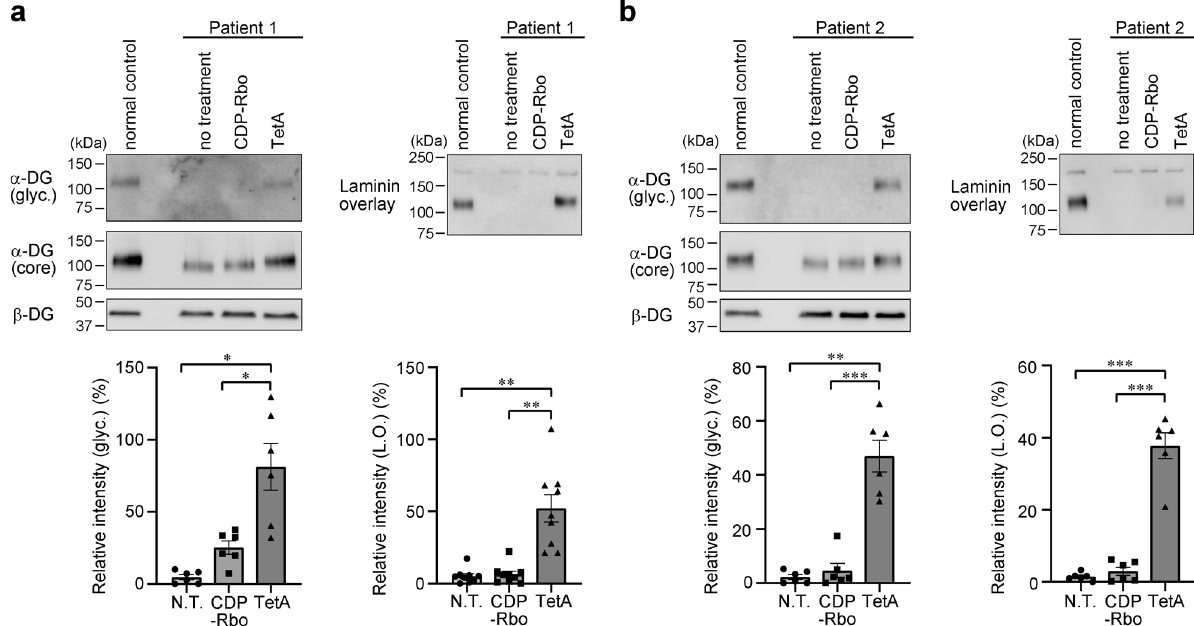
Fig. 6 CDP-Rbo(TetA) treatment recovers α -DG glycosylation in patient fi broblasts. Two different fi broblast cell lines derived from human patients ( a ; Walker-Warburg syndrome patient, b ; muscle-eye-brain disease patient) with ISPD-de fi ciency were treated with CDP-Rbo (200 μ M) or CDP-Rbo(TetA) (200 μ M) for 24 h. α -DG glycosylation was measured using western blot analysis with antibodies against matriglycan (glyc., IIH6) and core protein (3D7) or a laminin overlay assay. β -DG was used as a loading control. DG from normal human fi broblasts was used as a positive control. Bottom: relative matriglycan signal intensity (ratio of glyc./ β -DG) and laminin-binding activity (ratio of laminin binding/ β -DG) compared to those in normal human dermal fi broblasts (NHDF). All data represent the mean ± SEM. Data were analyzed using Brown – Forsythe and Welch ANOVA test followed by Dunnett ’ s T3 multiple comparisons (IIH6 of patient 1, p = 0.014, N.T. vs. TetA; p = 0.042, CDP-Rbo vs. TetA, n = 6; laminin overlay of patient 1, p = 0.002, N.T. vs. TetA; p = 0.003, CDP-Rbo vs. TetA, n = 9; IIH6 of patient 2, p = 0.002, N.T. vs. TetA; p = 0.0009, CDP-Rbo vs. TetA, n = 6; and laminin overlay of patient 2, p = 0.0005, N.T. vs. TetA; p = 0.0003, CDP-Rbo vs. TetA, n = 6). * p < 0.05, ** p < 0.01, and *** p < 0.001. TetA, CDP-Rbo(TetA). N.T., no treatment. L.O., laminin